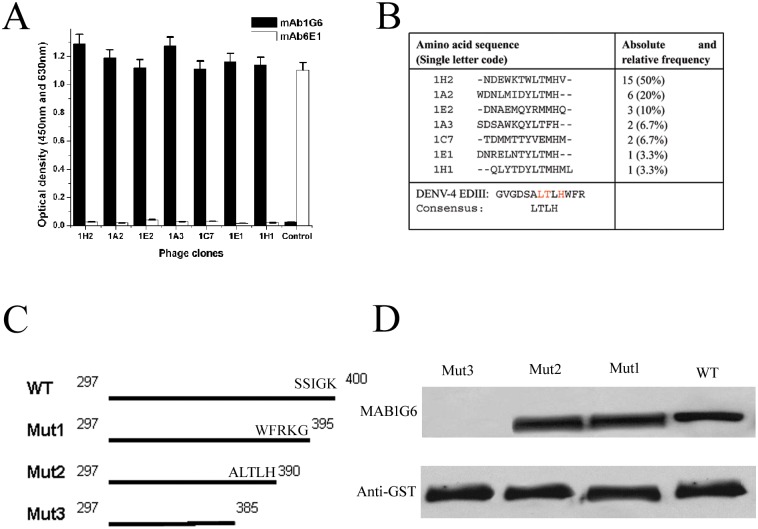
Epitope mapping of 1G6.
(A) Unique mAb 1G6-specific phages after three rounds of bio-panning. The binding of isolated phage clones to 1G6 was examined by ELISA. Data represent the mean ± S.D. of duplicate measurements. (B) Peptide insert sequences (single letter code) enriched after three rounds of selection. Selected peptide sequences are aligned for the consensus motif which is highlighted in bold letters. Binding of 1G6 to control phage clone and binding of control mAb 6E1 with 1G6-specific phage particles were included as specificity controls. Absolute frequency means the times that a specific phage-displayed peptide was identified; while relative frequency means the proportion of a specific phage-displayed peptide normalized by the total number of phage clones. (C) Schematic of generating truncated rED3 proteins. (D) Western blot of purified wild type and DENV4 rED3 truncations. The polyclonal antibody anti-GST was used as a positive control.